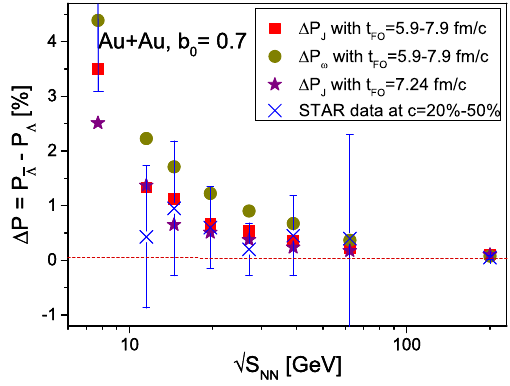
Fig. 5 Theaverage y -directedvorticity (cid:4)− ω y (cid:5) atfreezeoutasfunction of collision energy with impact parameter ratio b 0 = 0 . 7. The black and red symbols respectively represent the vorticity at fixed freeze-out time t FO = 7 . 24 fm/c, and at varied freeze-out time t FO = 5.9–7.9 fm/c the corresponding polarization is about 3.65%. Thus the